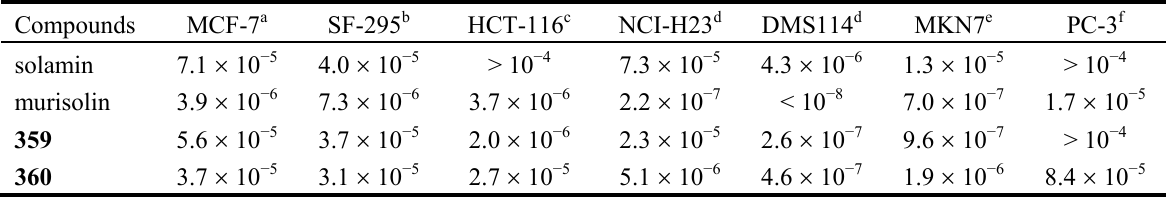
a breast cancer; b central nervous system cancer; c colon cancer; d lung cancer; e stomach cancer; f prostate